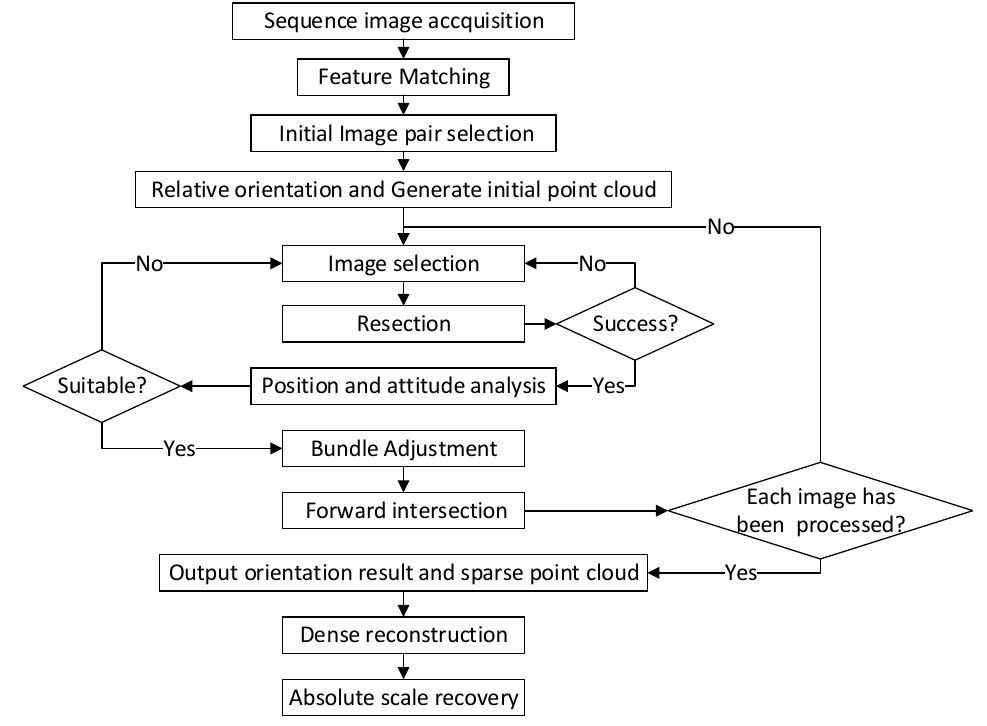
Figure 2. Multiview reconstruction process of the soil collection area.